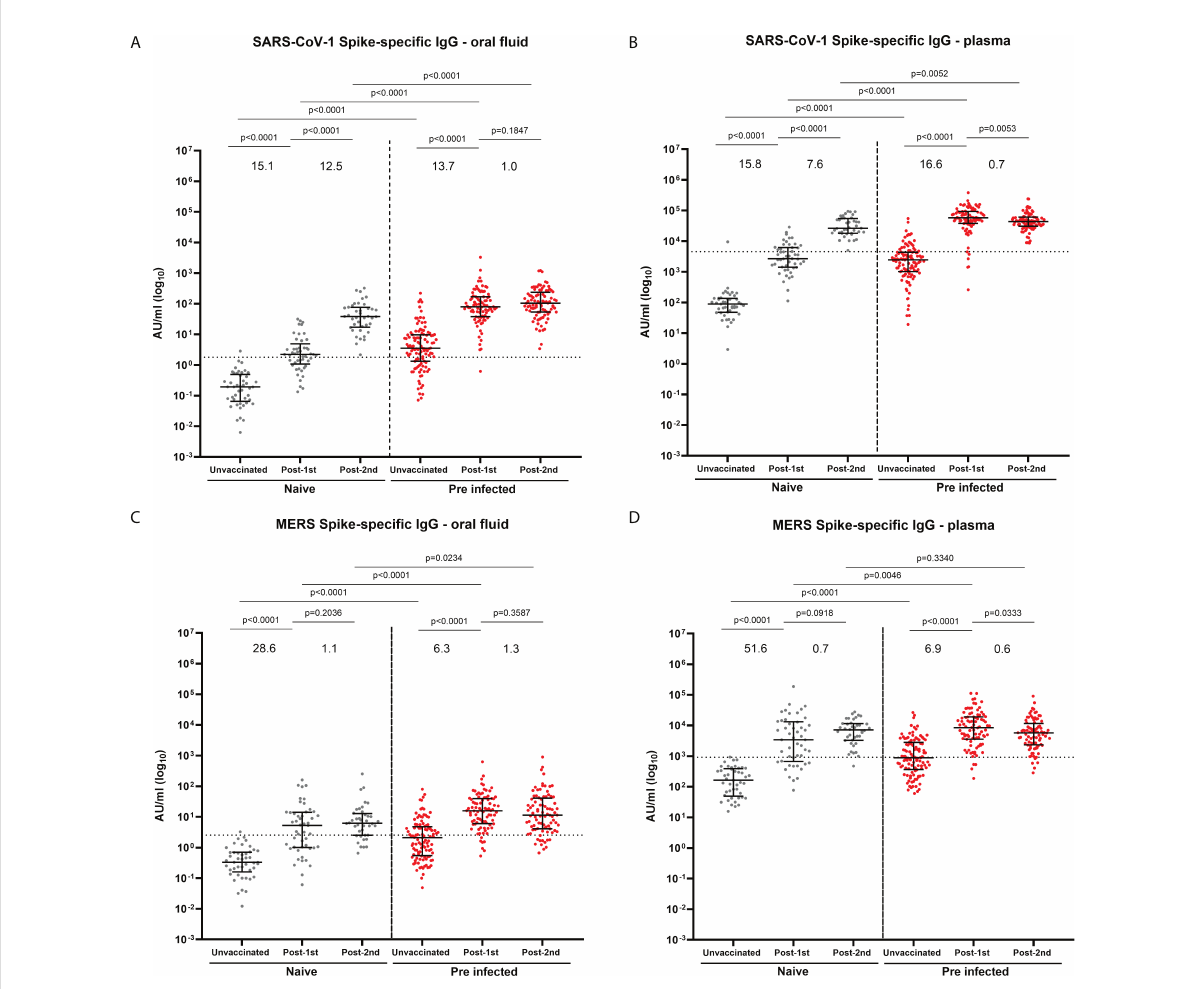
FIGURE 4 IgG responses to SARS-CoV-1 and MERS in oral fl uid and plasma. Concentrations (AU/ml) of S-speci fi c IgG to SARS-CoV-1 (A, B) and MERS S (C, D) in oral fl uid (A, C) and plasma (B, D) from naïve and previously-infected individuals measured by multiplex MSD ® immunoassay. Values above the columns show the fold increases in S-speci fi c IgG levels. Mann-Whitney tests were used to determine the statistical signi fi cance between the